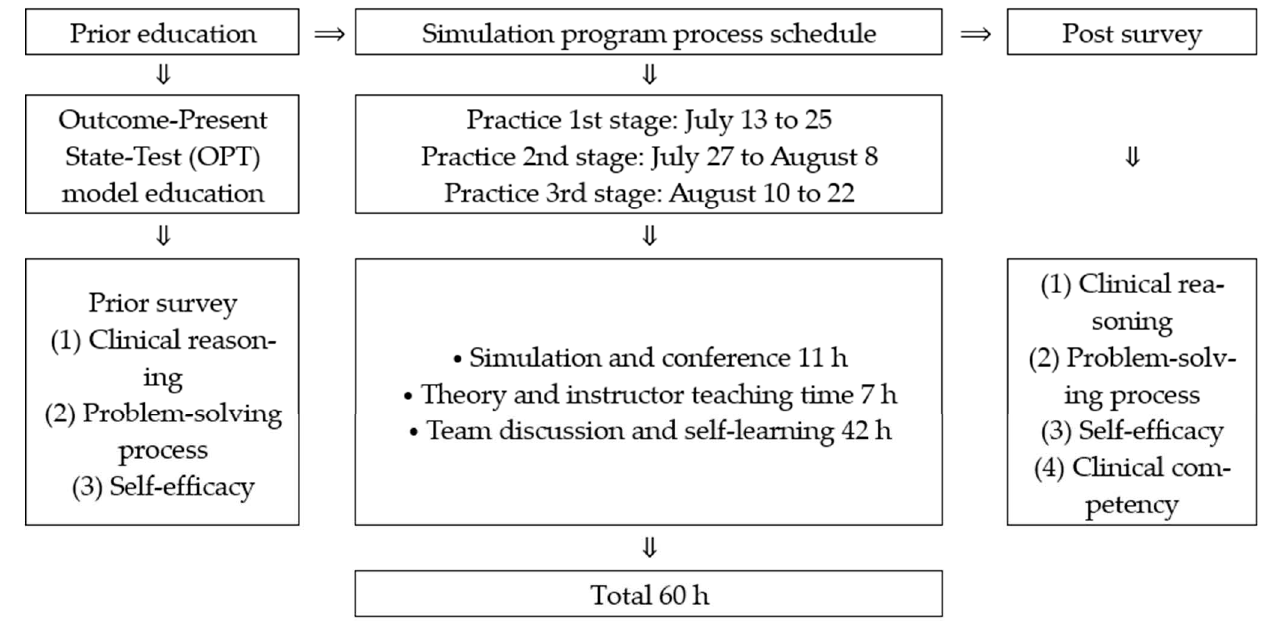
Figure 2. Process of simulation nursing education program using the OPT